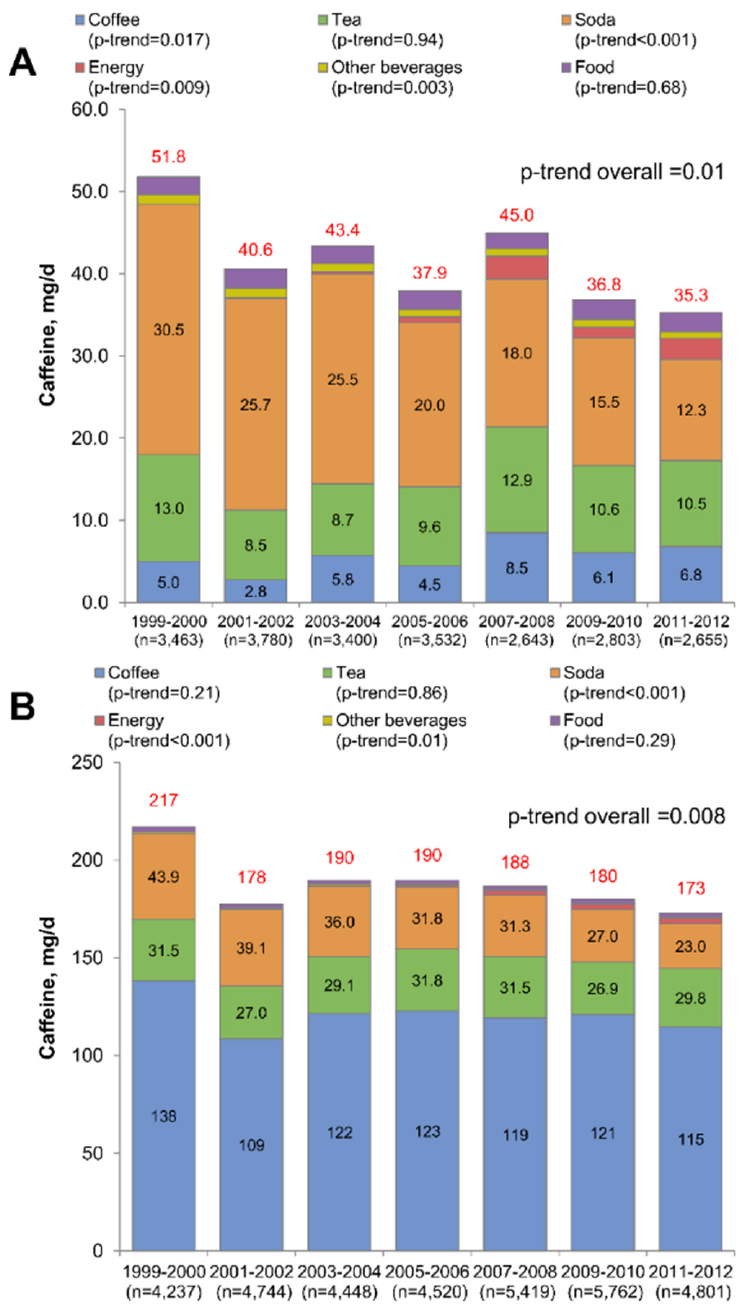
Figure 2. Trends in caffeine consumption overall and by source, stratified by age group. Data are for NHANES 1999–2012. Data are for ( A ) children; ( B ) Adults.